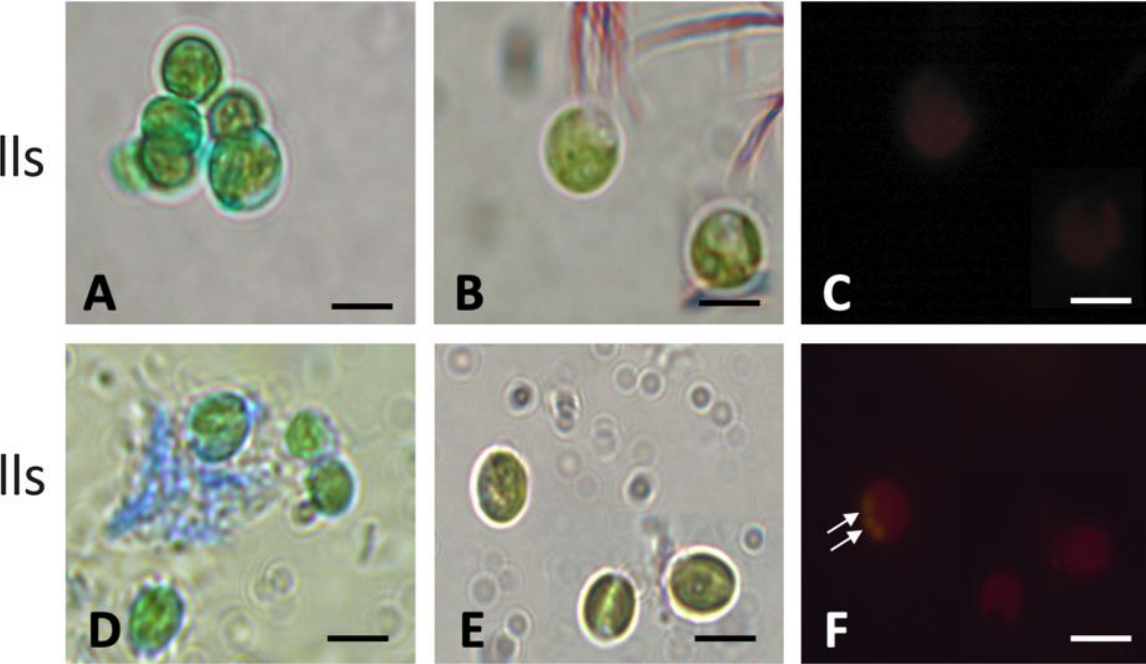
Figure 5. Light microscopy images of N. oleoabundans cells belonging to autotrophic ( A – C ) and mixotrophic ( D – F ) cultures at 28 and 12 d of cultivation, respectively. ( A , D ) Pictures taken on cell samples after Alcian Blue staining for exo-polysaccharide (EPS) detection. Blue coloration identifies EPS. ( B , C , E , F ) Pictures taken on cell samples after Nile Red staining for lipid droplets detection. In ( B , E ) images of Nile Red-stained cells at the conventional light microscope. In ( C , F ), images of the same cells reported in ( B , E ) but taken at the epifluorescence microscope (excitation wavelength = 485 nm). In ( C , F ), when present, lipid droplets appear as yellowish-gold globules (arrows). A-cells refer to algae in autotrophic cultures, while M-cells refer to algae in mixotrophic ones. Bars: 2.5 μm.